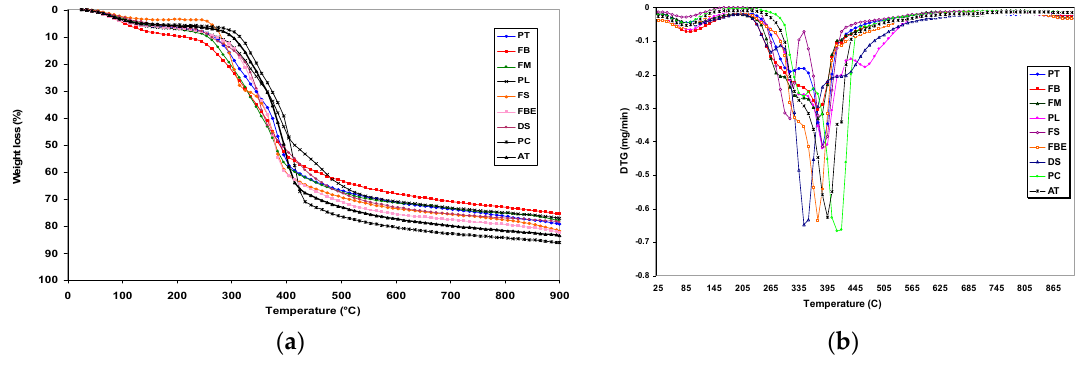
Figure 1. ( a ) TGA curves of the eight date palm residues and A. tortilis at heating rate of 10 °C/min; ( b ) DTG curves of the eight date palm residues and A. tortilis at heating rate of 10 °C/min. PT: palm trunk; PFB: palm frond base; PFM: palm frond midrib; PL: palm leaflets; PC: palm coir; FS: fruit stalk; DPS: date palm stone; FEB: fruit empty bunch; AT: Acacia tortilis .